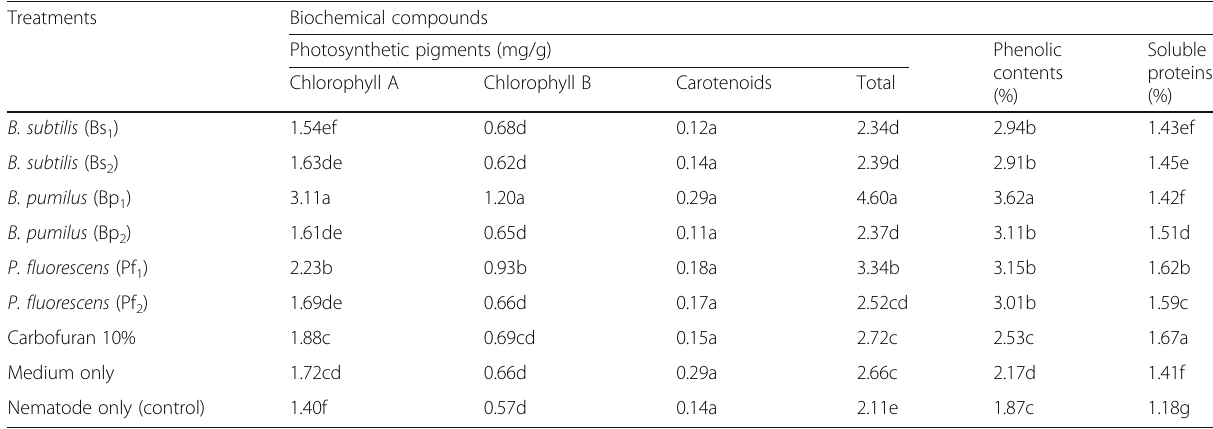
Table 4 Biochemical compounds in cowpea grown under screen house conditions and infected with root knot nematode, Meloidogyne incognita , as affected by Bacillus subtilis , B. pumilus , and Pseudomonas fluorescens